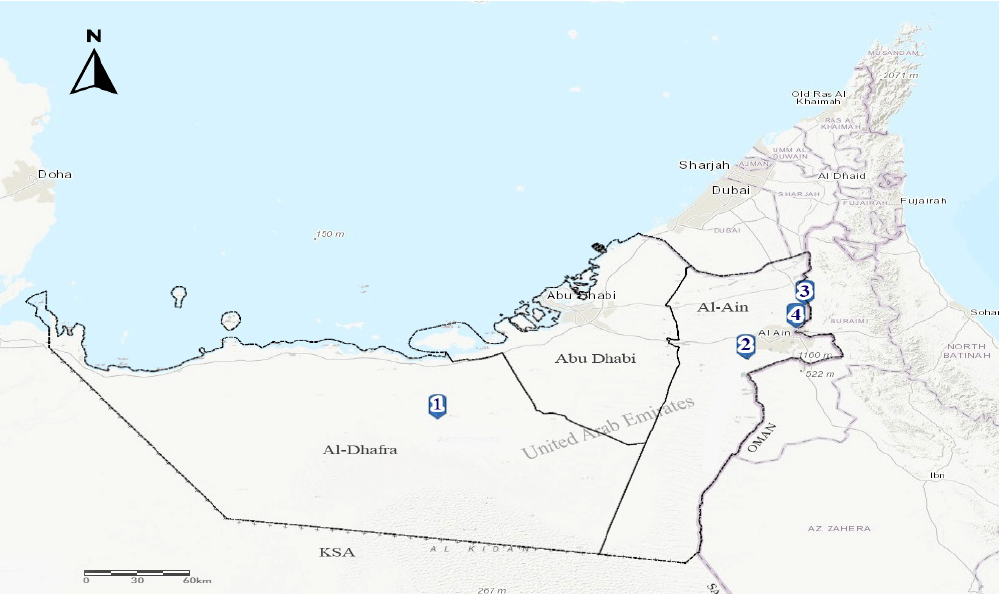
Figure 1. Map showing the location of the four PPRV infected farms in Al Ain region (Farms 2, 3 and 4) and Al Dhafra region (Farm 1), Abu Dhabi Emirate, UAE.